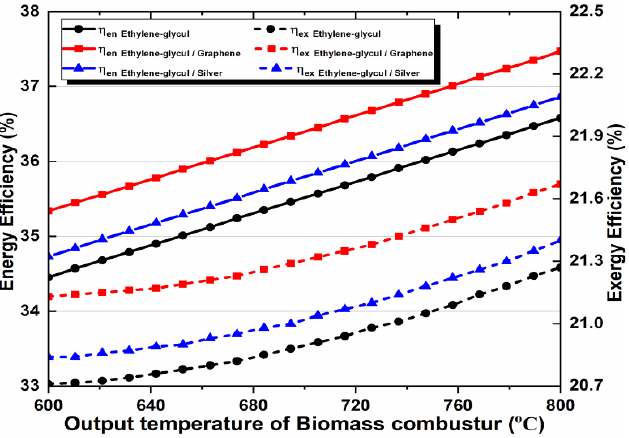
Figure 11. Effect of biomass combustor outlet temperature on energy and exergy efficiency.